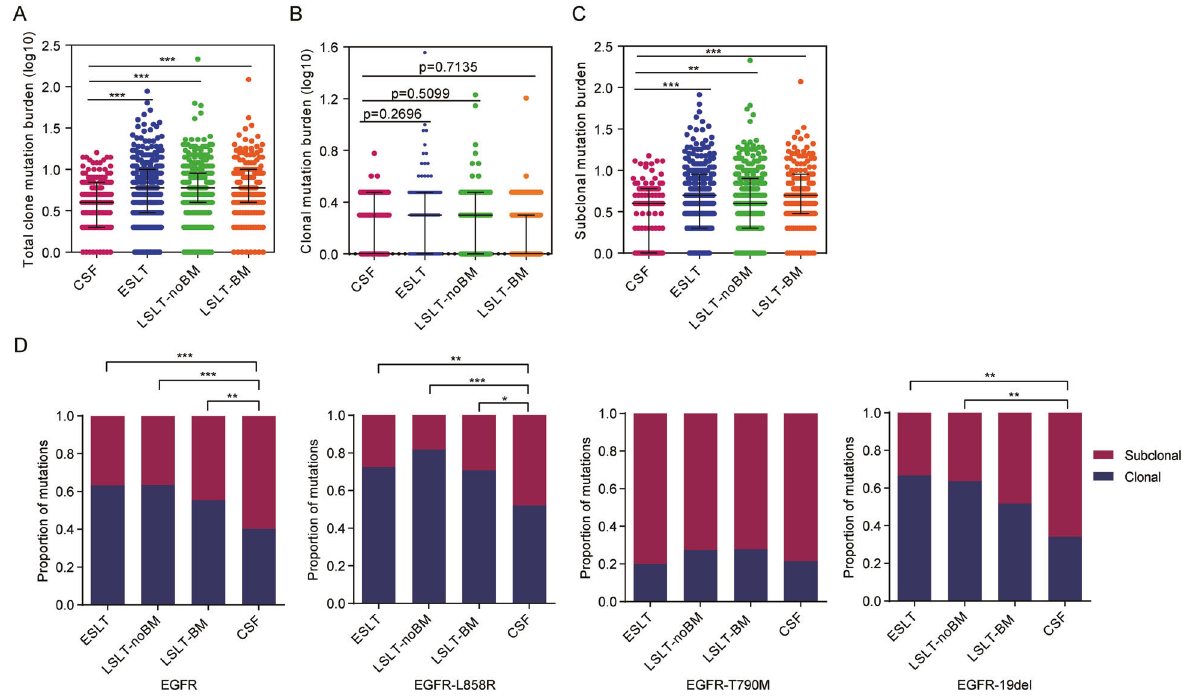
Fig. 7 Clonal and subclonal mutations in CSF and primary lung tumors. A – C Comparison of total clonal mutations burden (including clonal and subclonal), clonal mutation burden, and subclonal mutation burden in all somatic genes for CSF and the other three groups. Clonal mutations burden means the number of mutation clusters in each sample. Differences with signi fi cant P values are labeled (Mann – Whitney test). ** P < 0.01, *** P < 0.001. D The clonal and subclonal proportion of EGFR and EGFR genotyping (L858R, T790M, and 19del) in CSF and primary lung tissue. The differences of these clonal distribution were estimated by two-sided Fisher ’ s exact test. * P < 0.05, ** P < 0.01, *** P <